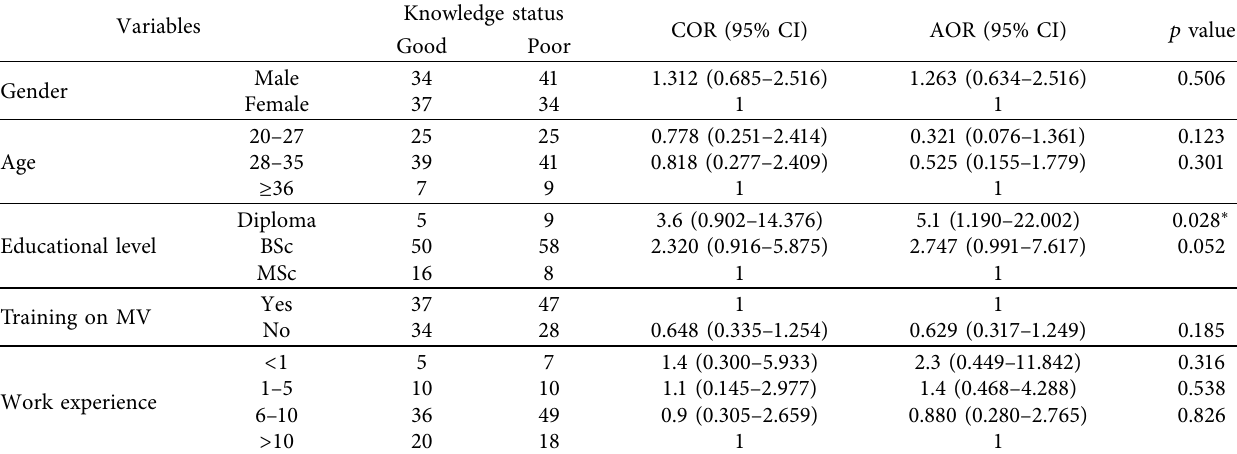
Table 4: Factors associated with the knowledge of nurses working in the ICU regarding mechanical ventilators ( N � 146). Variables